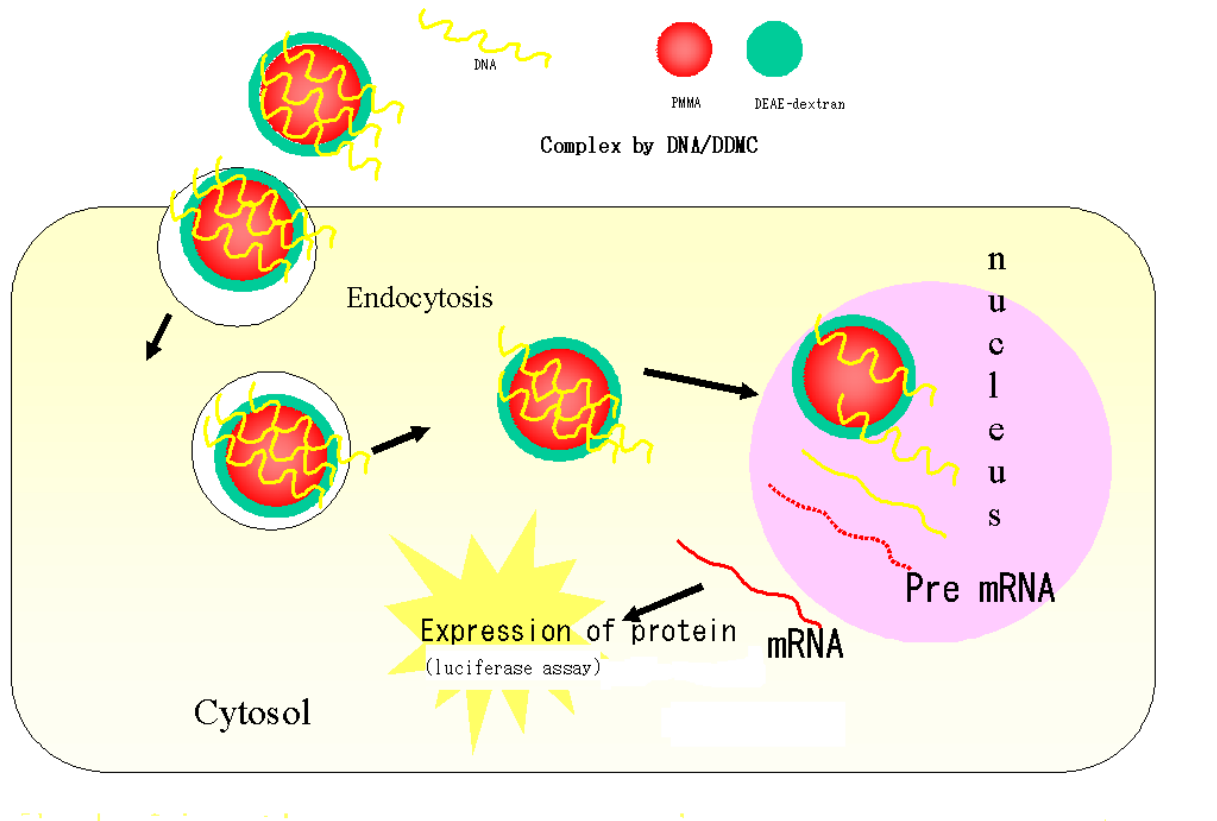
Figure 5. Schematic drawing of putative delivery pathways for foreign DNA complex with DEAE-dextran-MMA graft